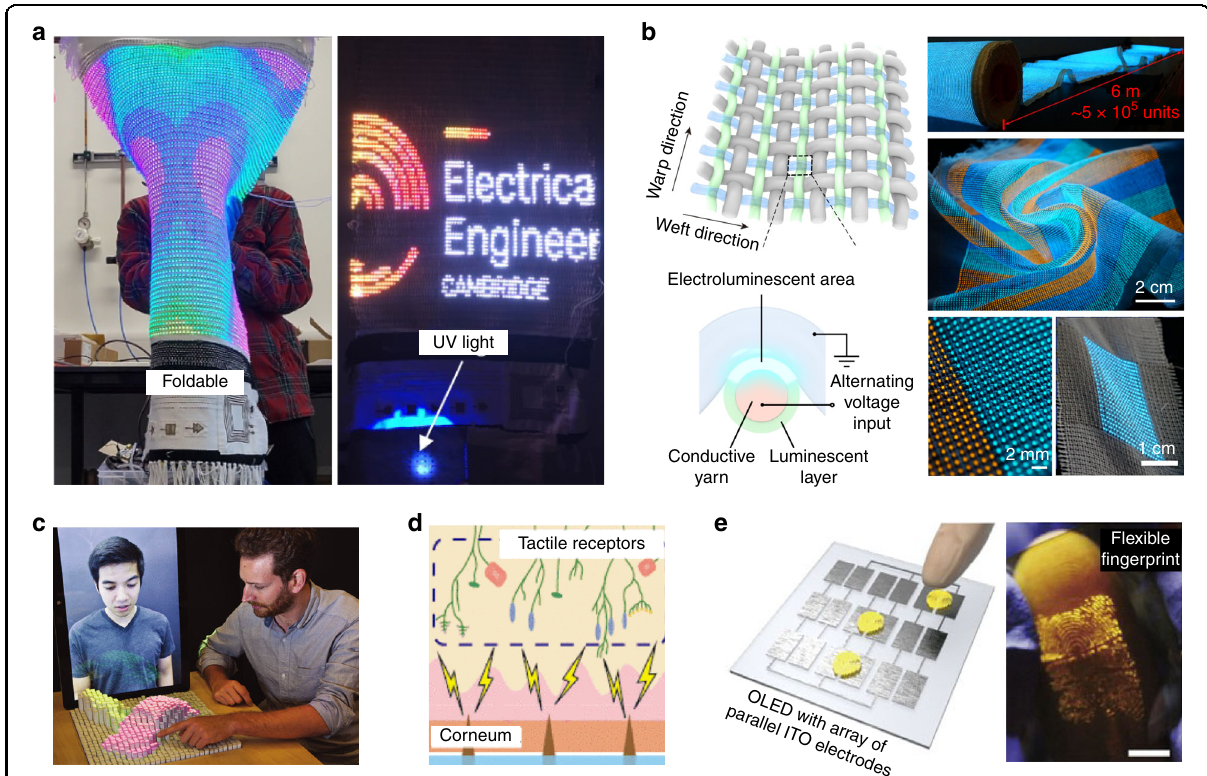
Fig. 7 Crumpable and feelable displays. a Deformable smart textile display system with multifunctional devices. The right photograph shows the fi ber photodetector that displays environmental UV light intensity. Reproduced with permission from ref. 55 Copyright 2022 Springer Nature. b Large- area ACEL textile display made by weaving conductive and luminescent fi bers. Reproduced with permission from ref. 56 Copyright 2021 Springer Nature. c 3D shape-morphing system with interactive interfaces composed of mechanical actuators and visual-tracking systems. Reproduced with permission from ref. 60 Copyright 2015 IEEE. d Electric stimulation of the human skin mechanoreceptors. Reproduced with permission from ref.